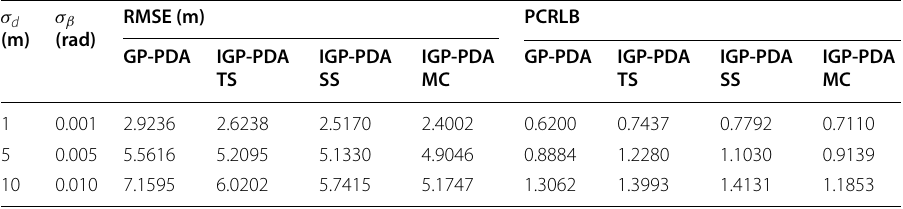
Table 3 Effect of measurement noise on centroid estimates RMSE and PCRLB in first scenario σ d σ β (m) (rad)